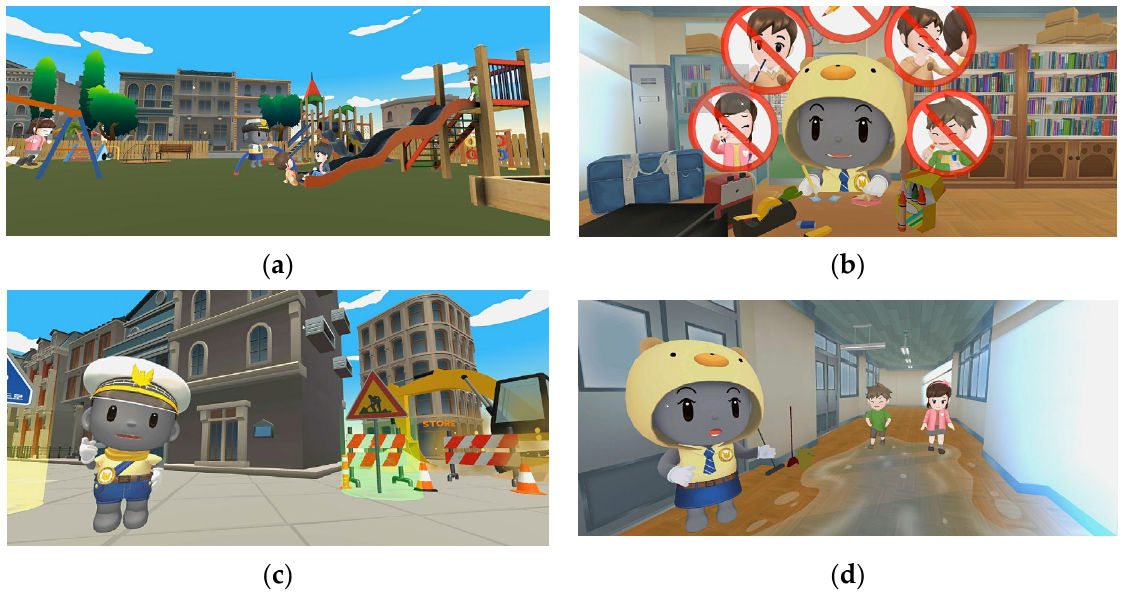
Figure 4. Life safety content image through a VR device. ( a ) Instructions for the playground. ( b ) Safe handling of art supplies. ( c ) Moving safely on the road in the presence of construction. ( d ) Passing safely through slippery areas.